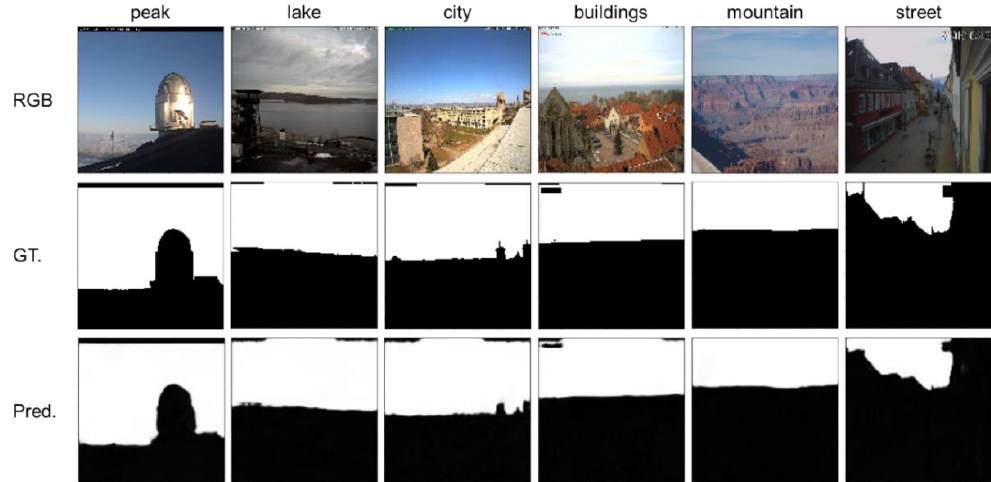
Figure 9. The result of the pre-trained network in normal visual conditions of the Skyfinder dataset. “RGB”, “GT.”, and “Pred.” refer to the input source images, the ground-truth annotations, and the predictions of the proposed NI-U-Net, respectively. “peak”, “lake”, “city”, “buildings”, “mountain”, and “street” refer to some example scenes in the Skyfinder dataset.